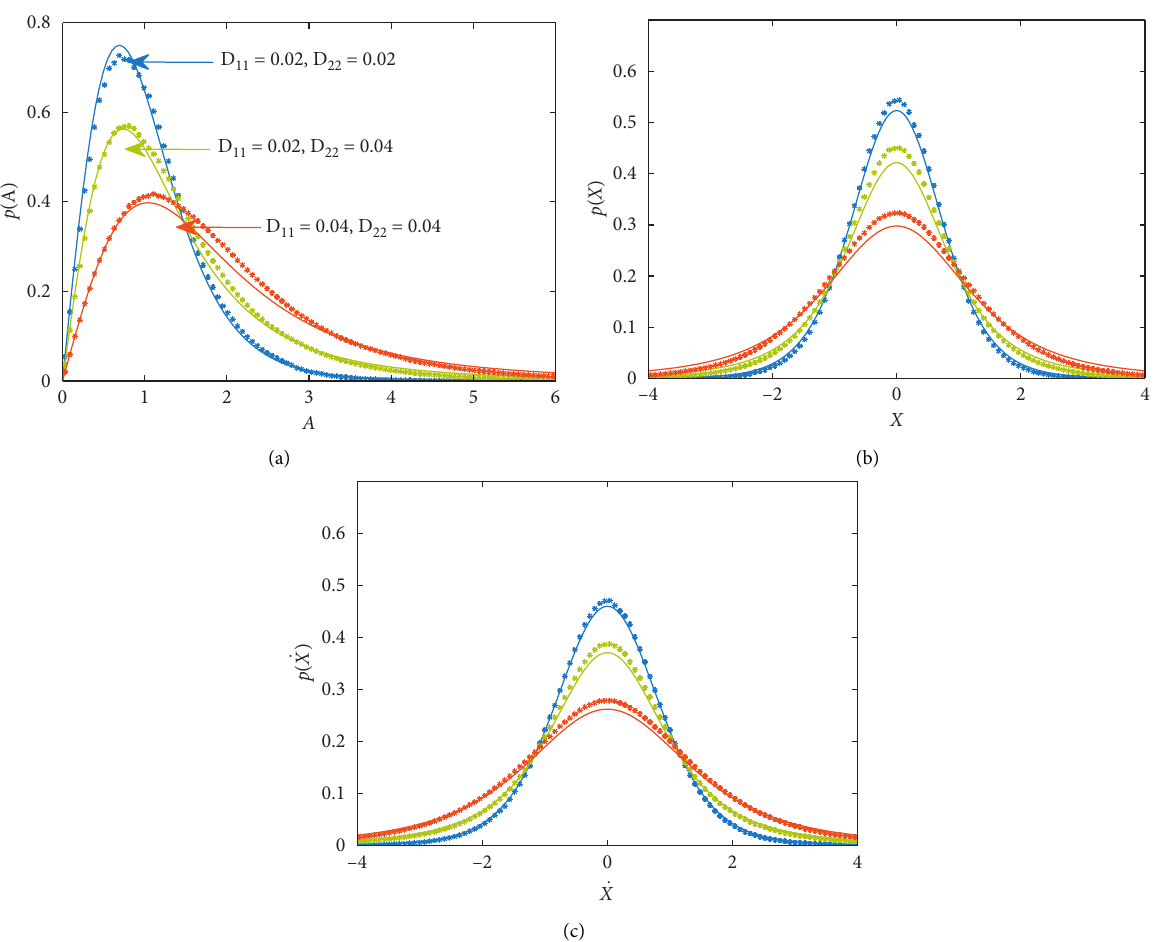
Figure 2: The stationary PDFs under different noise intensities: (a) amplitude, (b) displacement, and (c) velocity. Theoretical analysis results (-) and Monte Carlo simulation results ( ∗